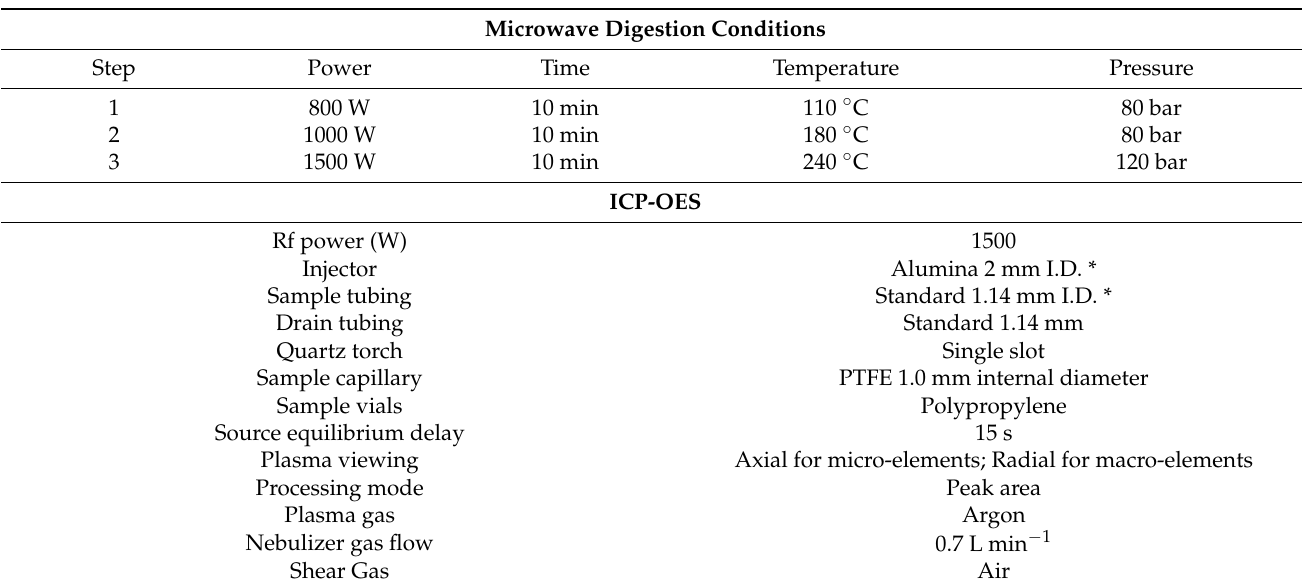
Table 2. Microwave oven and ICP-OES condition